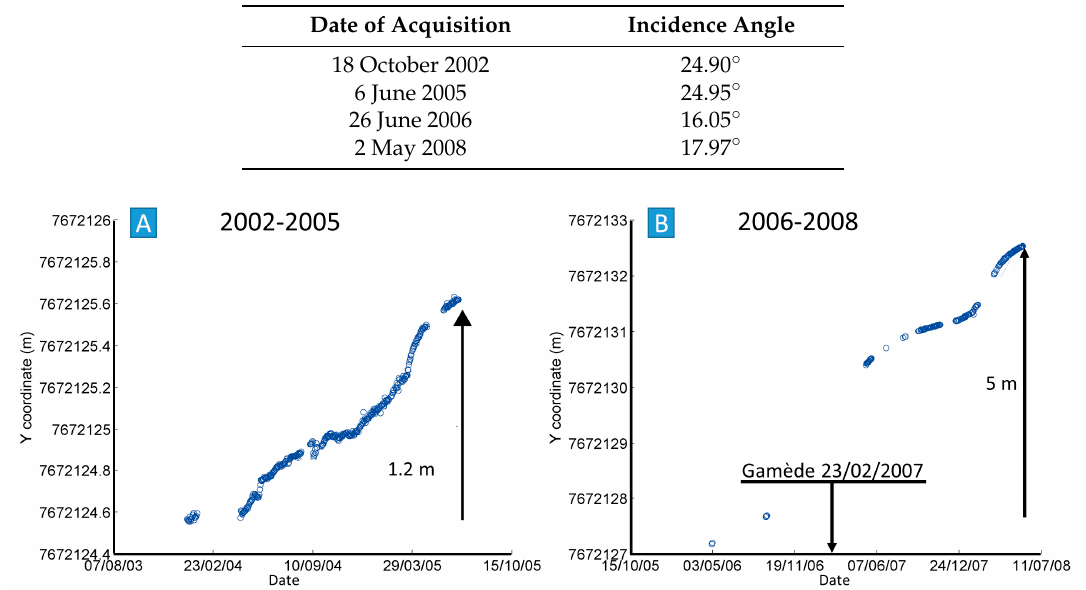
Table 1. Date of acquisition and incidence angle of the SPOT-5 images.